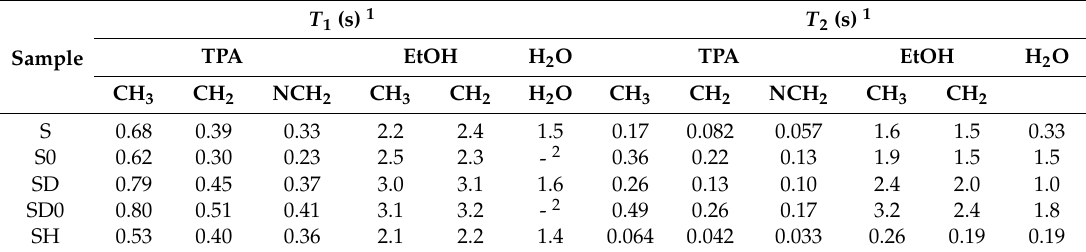
Table 2. Longitudinal ( T 1 ) and transverse ( T 2 ) relaxation times (in s) of the 1 H resonances obtained for TPA, ethanol and water in the different